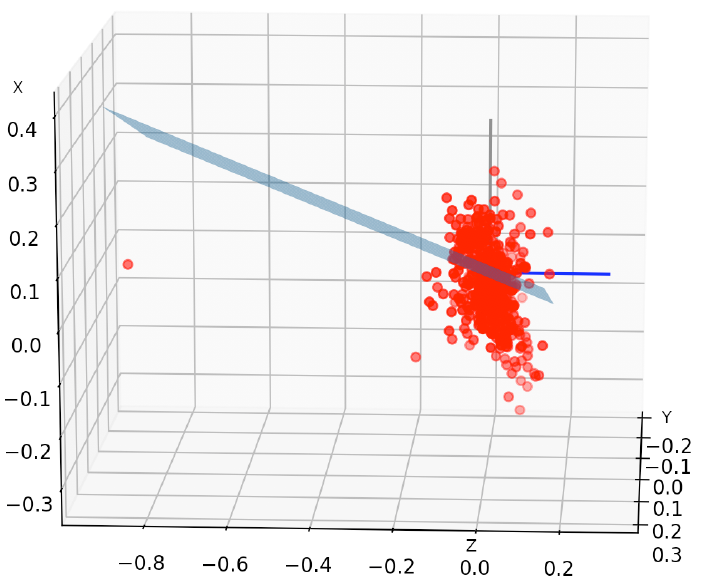
Figure 3. Outliers removal from 3D distribution of acceleration points—values are in m/s 2